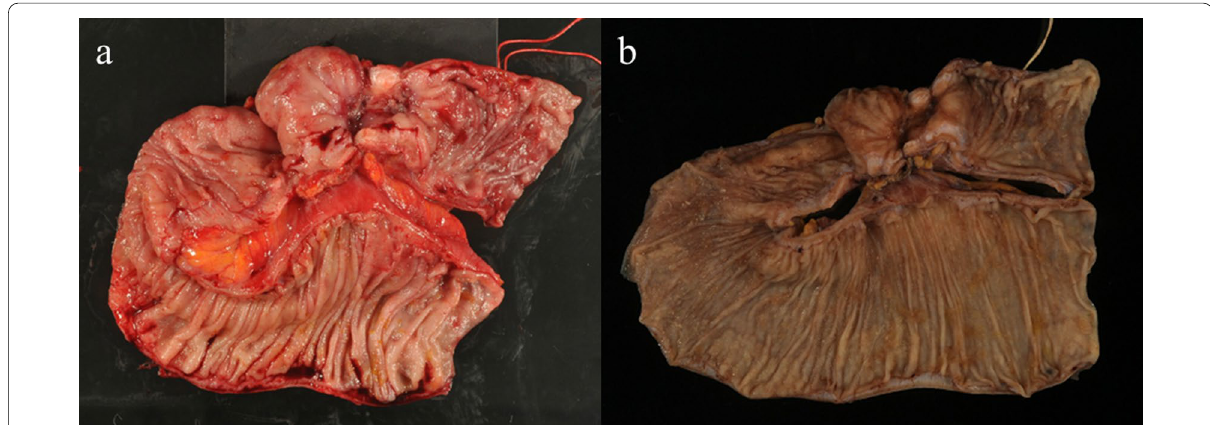
Fig. 4 Gross specimen. Gross appearance revealed deep ulceration that penetrates the mesentery and caused stenosis of the ileum and the dilated proximal bowel ( a fresh, b after formalin fixative)